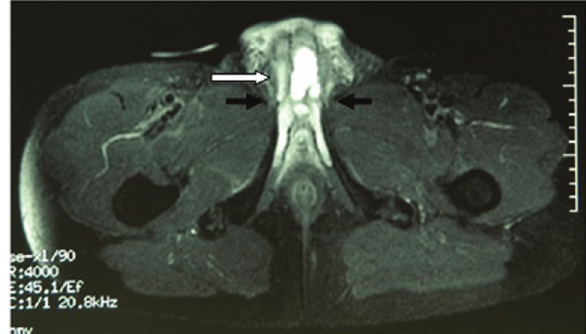
figure 1 - T2 weighted MRI revealed a transverse fracture across the corpora cavernosa (black arrows). Minimal extravasation of blood is noted on the right juxta-coporal extending through the tunica albuginea, but contained within Buck’s fascia (white arrow).